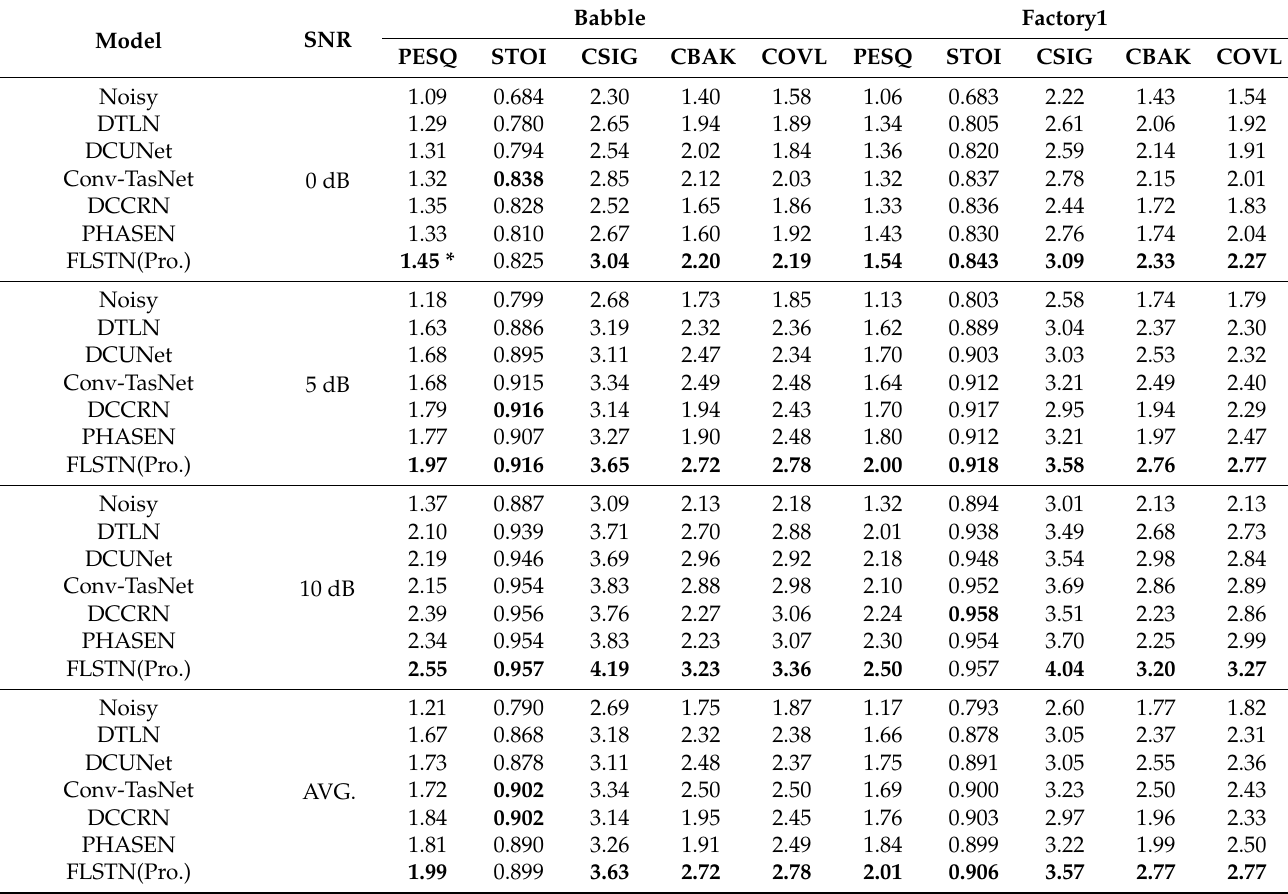
Table 1. Experimental results on WSJ0-babble and WSJ0-factory1 evaluation sets.